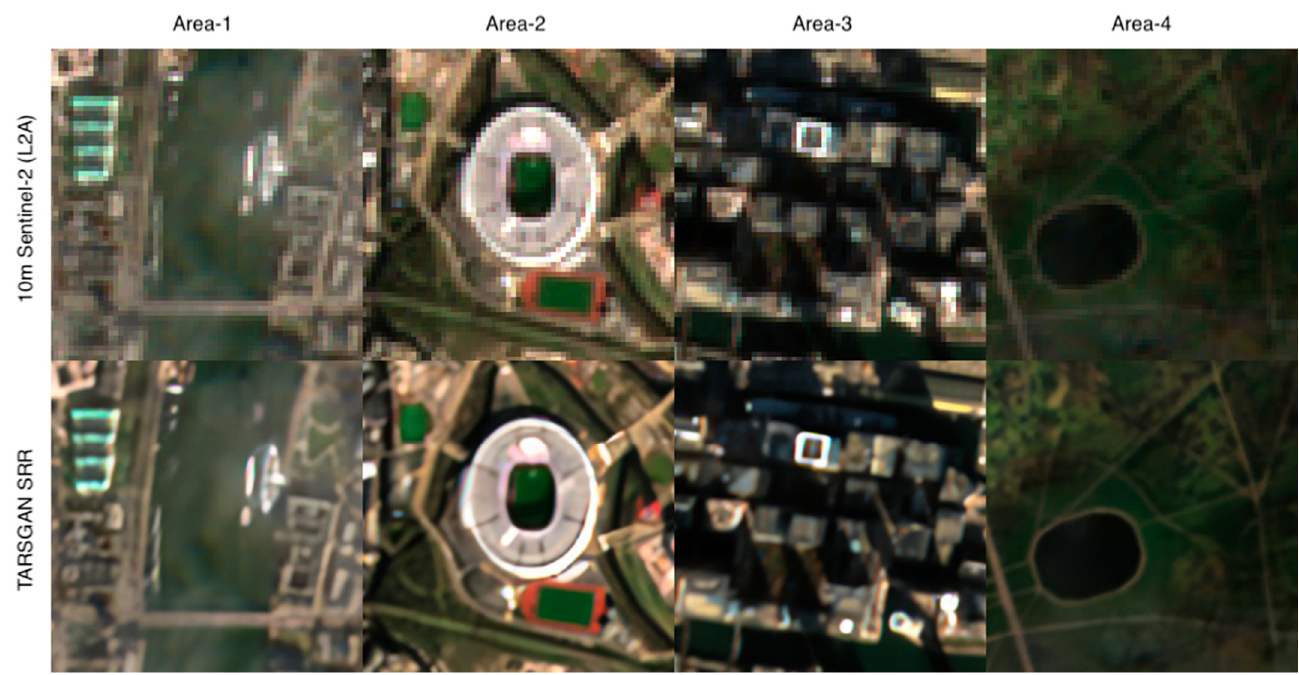
Figure 12. Cropped examples ( 625𝑚 × 625𝑚 ) of the 10m/pixel Sentinel-2 “true” colour images (L2A) and TARSGAN SRR result over London, UK (Site-4). Please refer to supplementary material for full-size SRR (produced from Sentinel-2